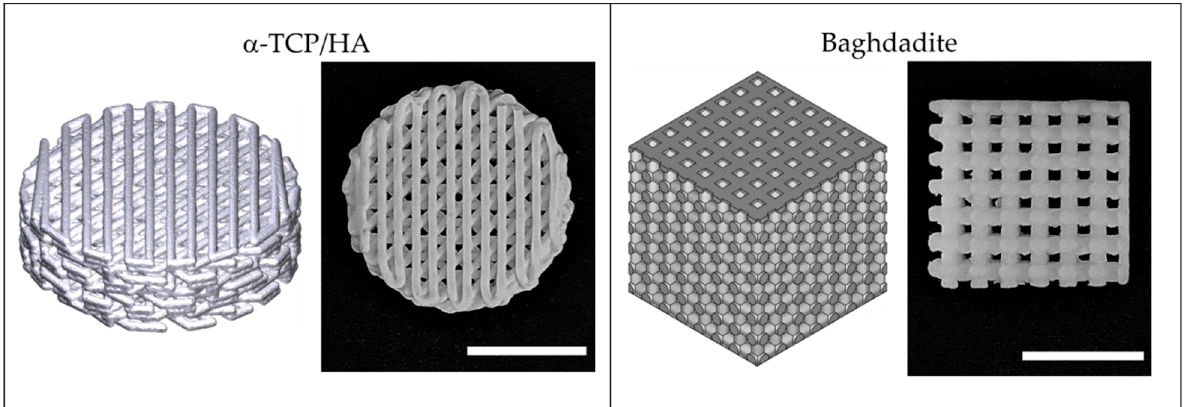
Figure 1. 3D-printed scaffolds fabricated from α -TCP/HA calcium phosphate cement and baghdadite–calcium silicate-based ceramic used in this study. Both scaffold types are illustrated as 3D models ( left ) and photographs ( right ). Scale bar: 5 mm.